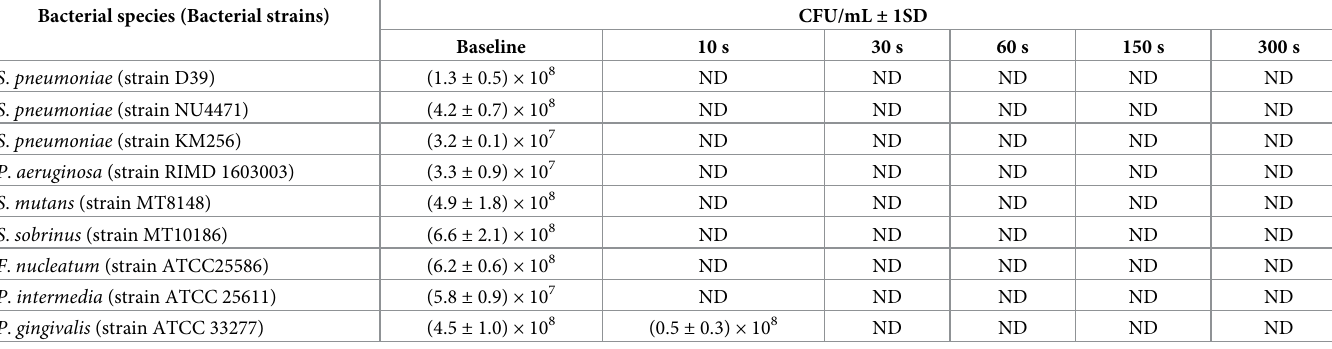
The number of colony-forming units (CFU) of various bacterial species was measured after exposing to ozone ultrafine bubble water containing 4–6 ppm of ozone for 10–300 s. ND stands for undetected and indicates below the detection limit ( < 100